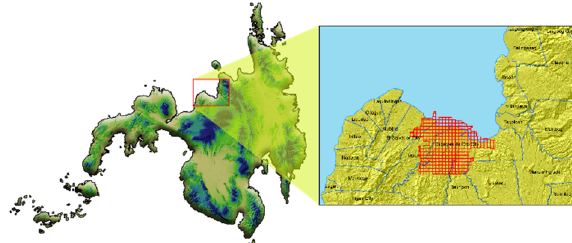
Figure 1. Study site situated between the portions of Cagayan de Oro and Opol, Misamis Oriental, Philippines.